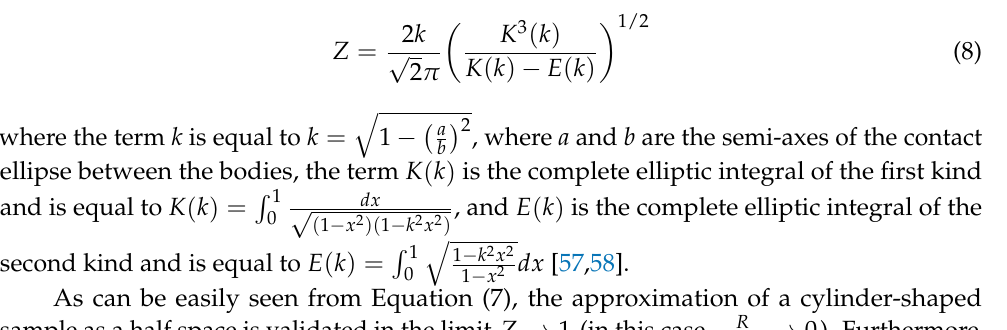
Figure 4. Indentation experiment on a cylinder-shaped homogeneous and isotropic sample. The AFM tip can be approximately considered as a rigid spherical indenter for small indentation depths.